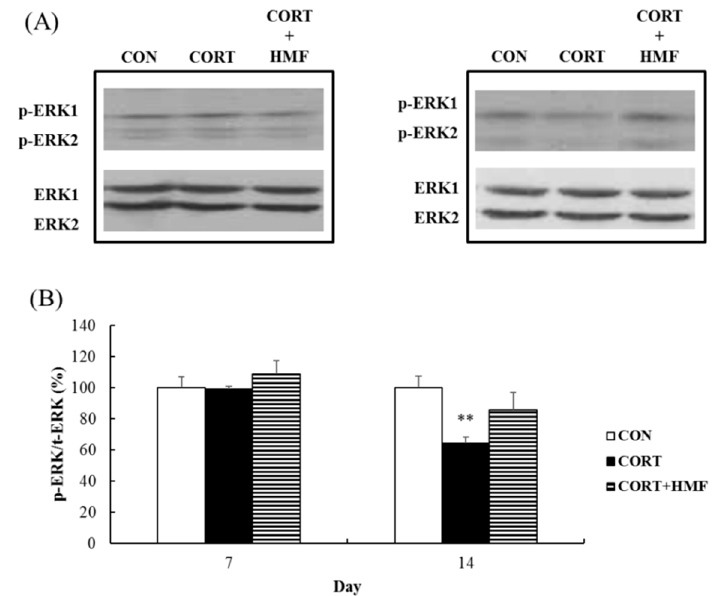
Figure 7. A Western blot analysis of the influence of HMF on the expression of phosphorylated ERK in the corticosterone-induced depressive mouse hippocampus. ( A ) Representative band patterns of p-ERK1/2 and ERK1/2. ( B ) A quantitative analysis of the p-ERK/ERK ratio using ImageJ software. Values are means ± SEM (Day 10; n = 4, Day 17; n = 5). Symbols show significant differences between the following conditions: CON vs. CORT (** p < 0.01).